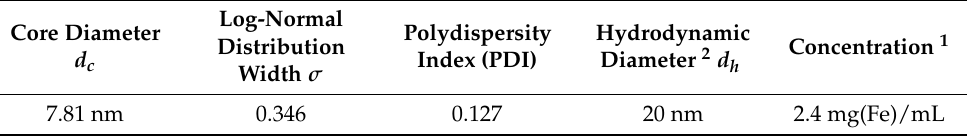
Table 2. Material properties of MNPs from fitting the experimental data with the Langevin model.